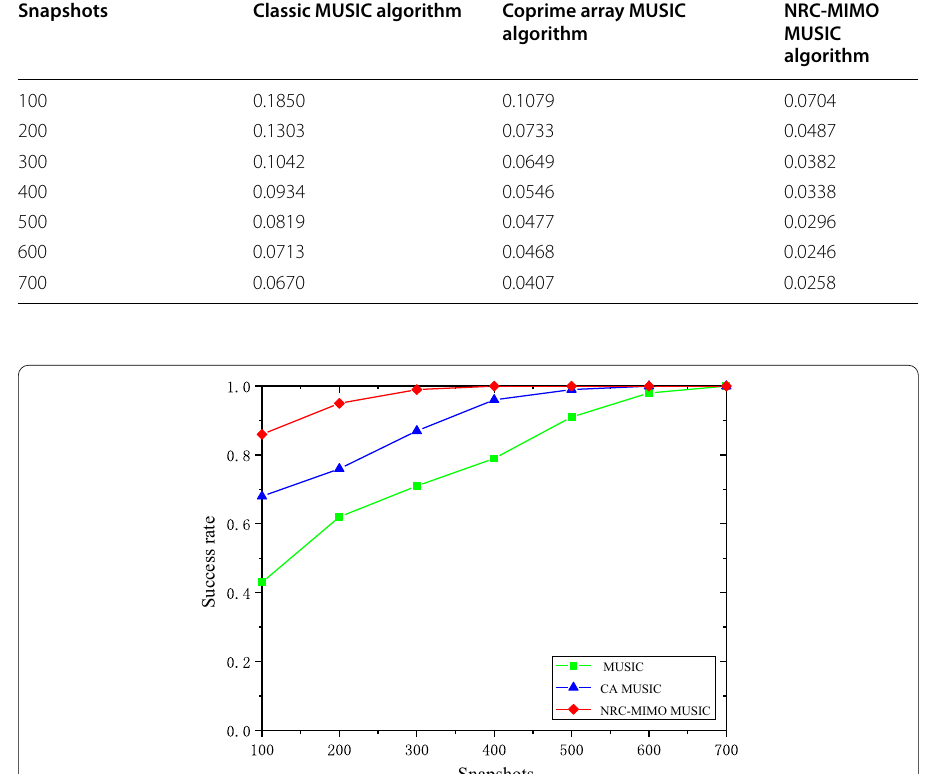
Fig. 7 The success rate of target detection varies with the number of snapshots